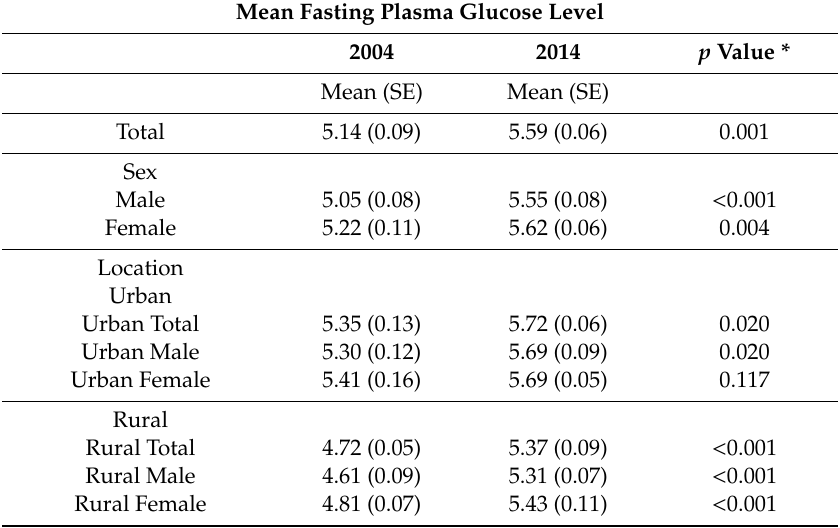
Table 3. Age-standardized mean fasting plasma glucose level among 25–74-year-old-citizens in Yangon Region, Myanmar in 2004 and 2014.